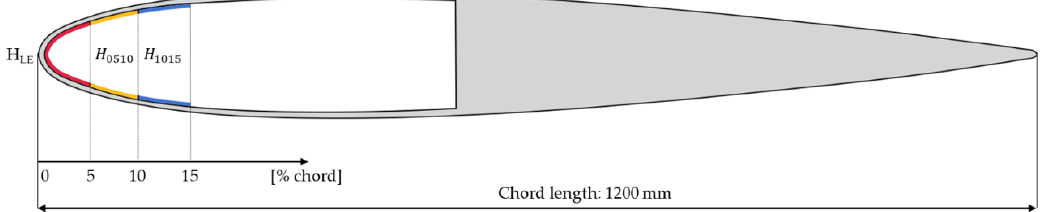
Figure 4. Schematic of NACA0012 model for the demonstration test.